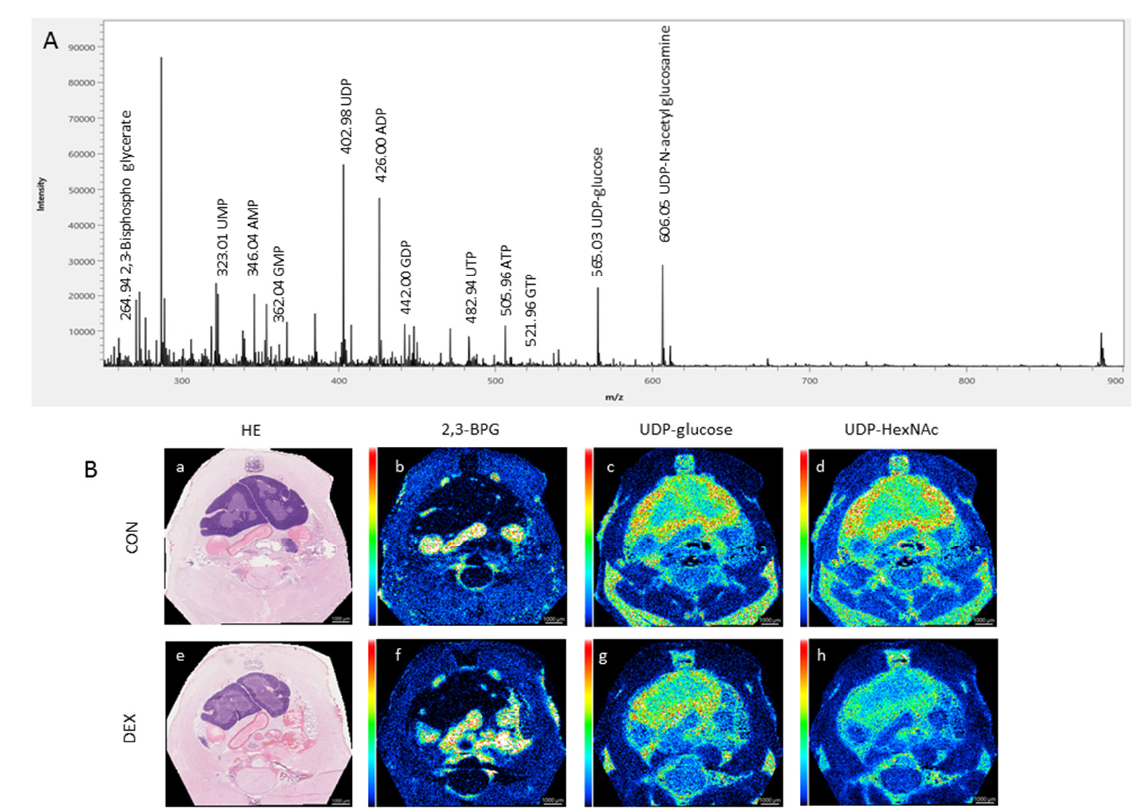
Figure 3. Thoracic Mass Spectrometry Imaging (tMSI). ( A ) Average mass spectrum of the normal murine thorax section obtained from MALDI–IT-TOF analyzer in the negative-ion mode. The signals were obtained ranging from m/z = 250 to 900. Annotated single peak with qualified metabolites in the current literature and by ourselves are shown. ( B ) MSI clarifies the localization of 2, 3-BPG ( b , f ), UDP-glucose ( c , g ), and UDP-HexNac ( d , h ) shown as a heat map mode. HE staining from control (CON) and DEX treated mice, were shown (as ( a ) and ( e ), respectively). Color scale for 2, 3-BPG ( b , f ) was 0 to 21.237%, for UDP-glucose ( c , g ) was 0 to 43.871%, and for UDP-HexNac ( d , h ) was 0 to 42.86%, respectively.